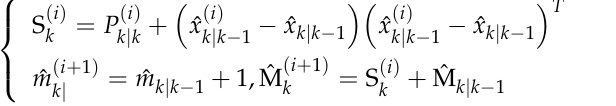
Figure 4. Schematic diagram of Outlier Replacement. Enter the fixed-point iterative update process after initializing the parameter values. The first is to update the approximate probability density function ˆ P step forecast covariance matrix. Equation (44) gives the calculation process.